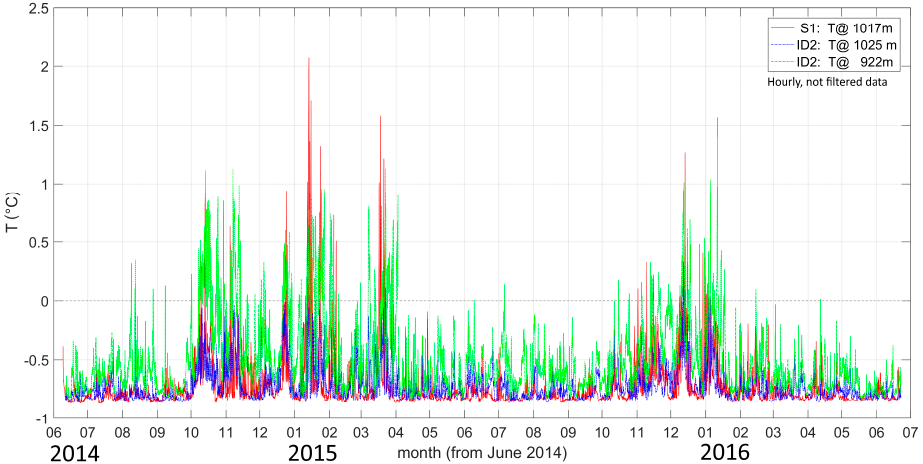
Figure 6. In situ temperature time series at S1 (red) and ID2 (blue and green). Data cover the period from June 2014 to June 2016 (for the position of the moorings refer to Figure 1).